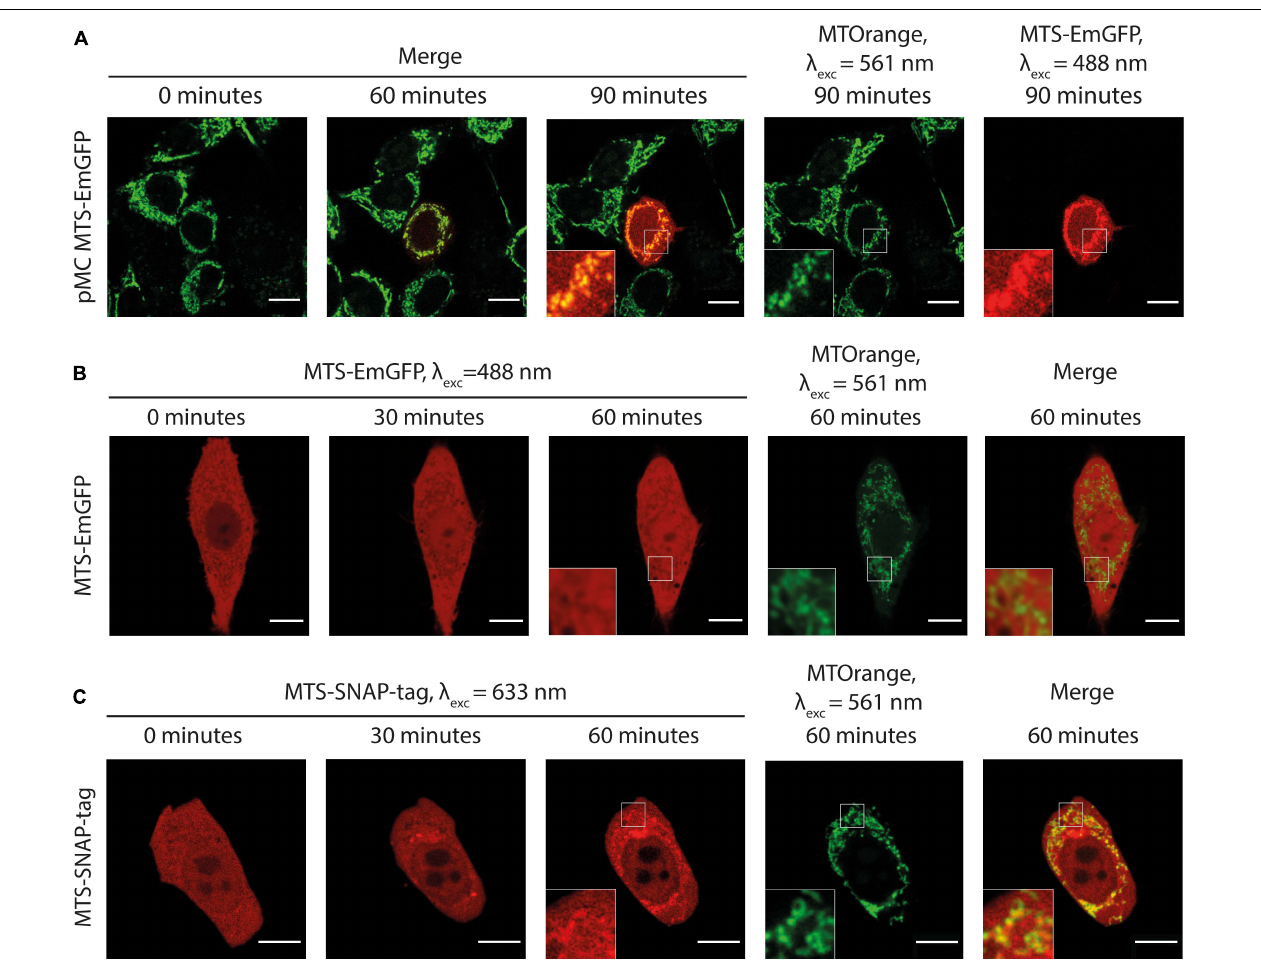
FIGURE 2 | (A) Time-lapse microscopy of MTS-EmGFP (red) expression after the injection of the expression vector pMC-MTS-EmGFP in HeLa cell in the center of the image. MTS-EmGFP fluorescence is observed first at ca. 60 min and intensifies for several hours. The mitochondrial network labeled by MTOrange (green) appears normal at all times after the injection, and the newly synthesized and matured MTS-EmGFP localizes in the mitochondria. (B) Time-lapse microscopy of the injected MTS-EmGFP protein distribution in the HeLa cells. The MTS-EmGFP (red) evenly distributes inside the cytoplasm and nucleus, while the mitochondria labeled by MTOrange (green) are visible as regions with a lower fluorescence intensity (“shadows”), which correlates well with the strong fluorescence at the corresponding pixels in the MTOrange image. (C) Time-lapse microscopy of injected MTS-SNAP-tag protein in HeLa cells. The MTS-SNAP-tag (red) fluorescence distribution shows structures with a higher fluorescence intensity spatially correlating with the MTOrange labeled mitochondrial network (green) from 30 min after the injection, seen more clearly 60 min after the injection. Scale bars: 10 µ